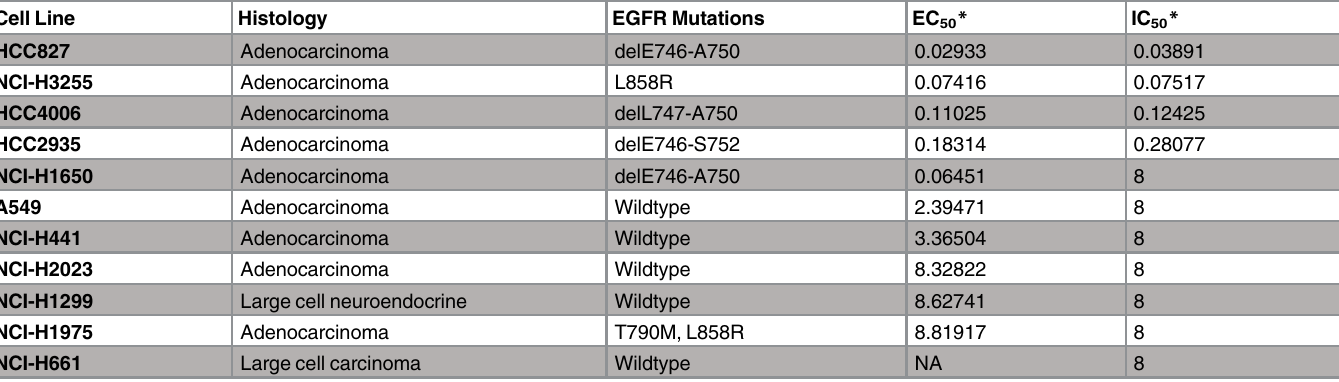
* EC 50 (half maximum effective concentration) and IC 50 (half maximum inhibitory concentration) of Erlotinib for various lung cancer cell lines have been previously reported in